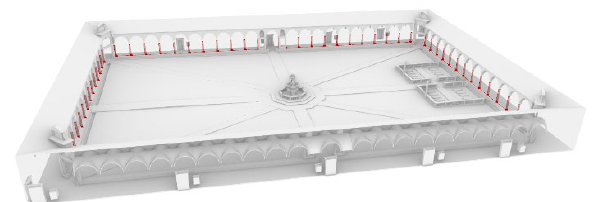
Figure 10. Resulting conceptual model for the Grand cloister.